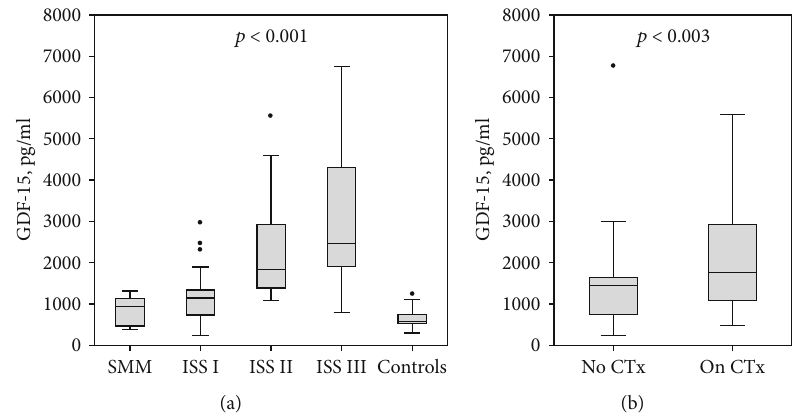
Figure 1: Serum GDF-15 concentrations according to incremental MM disease stages with reference controls (a) and among patients receiving no chemotherapy (CTx) treatment versus those on chemotherapy at baseline (b). Data are shown as median (horizontal line), interquartile range (box), nonoutlier range (whiskers), and outliers (points); p value is shown for overall comparison between groups. The numbers of patients in each group are reported in Table 2. SMM: smoldering myeloma; ISS: International Staging System for multiple myeloma.